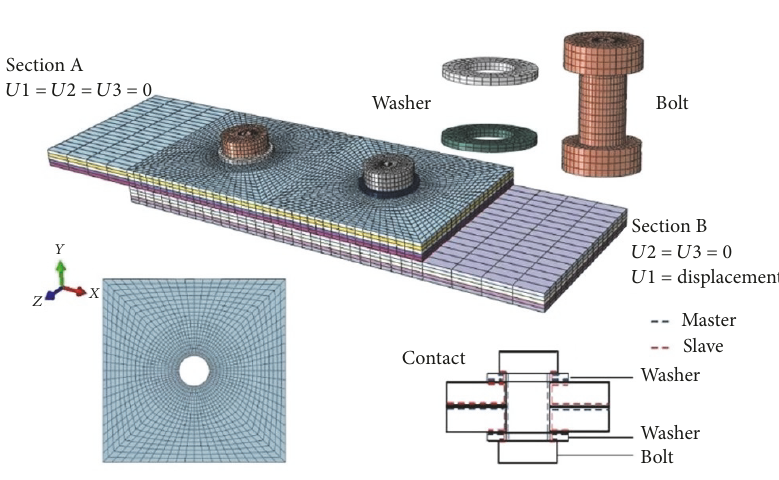
Figure 5: FEA model and interactions of bolted